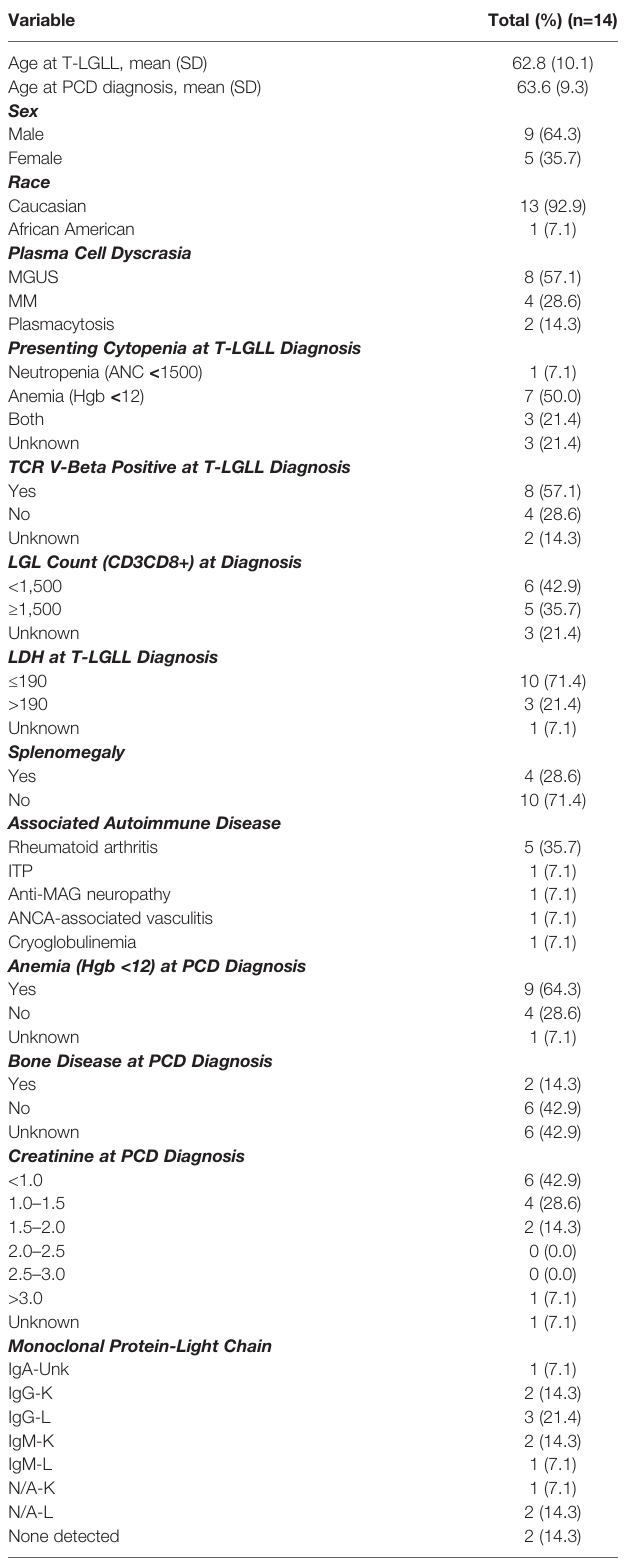
TABLE 2 | Baseline characteristics for patients with